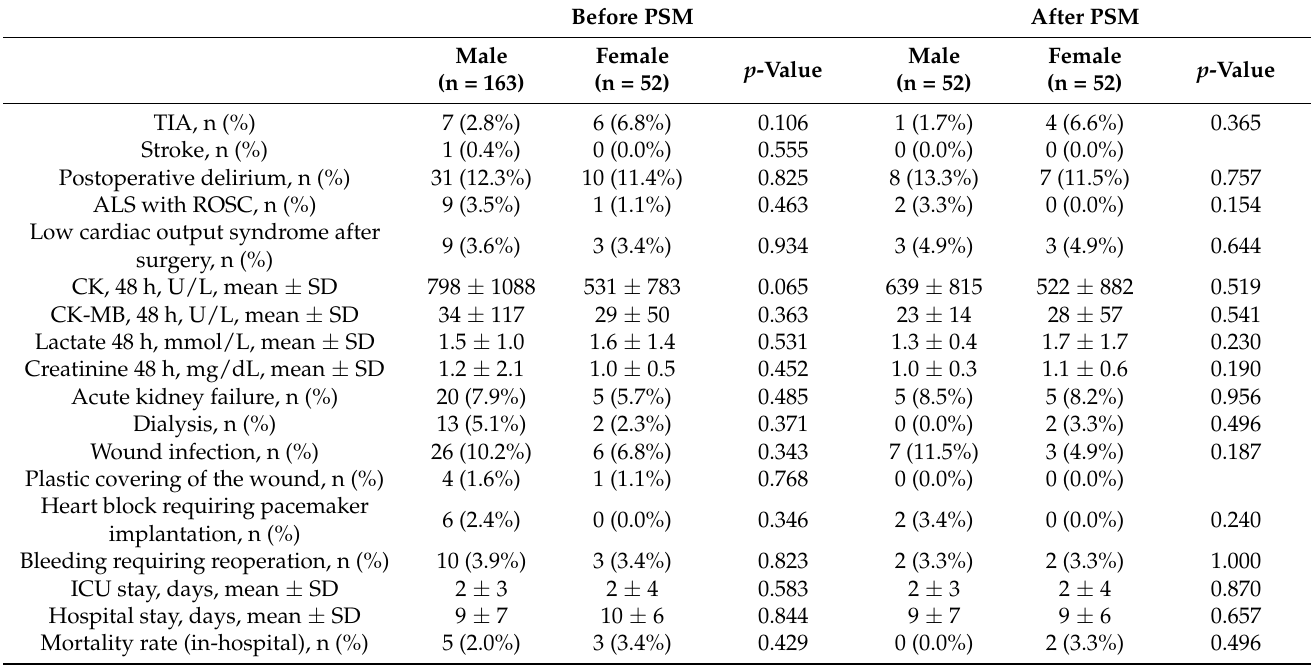
Table 3. Postoperative